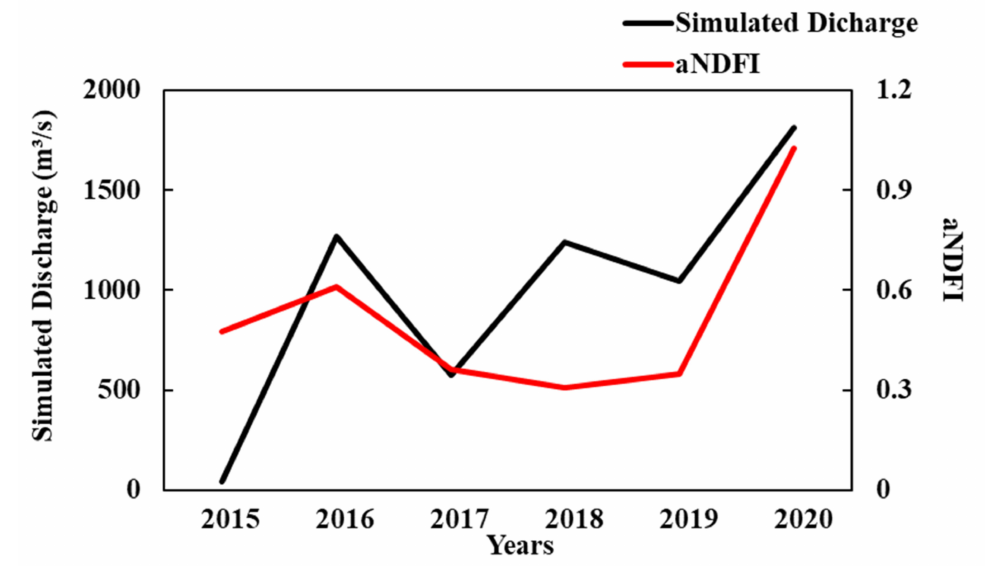
Figure 7. Annual maximum flood events aNDFIm year and simulated